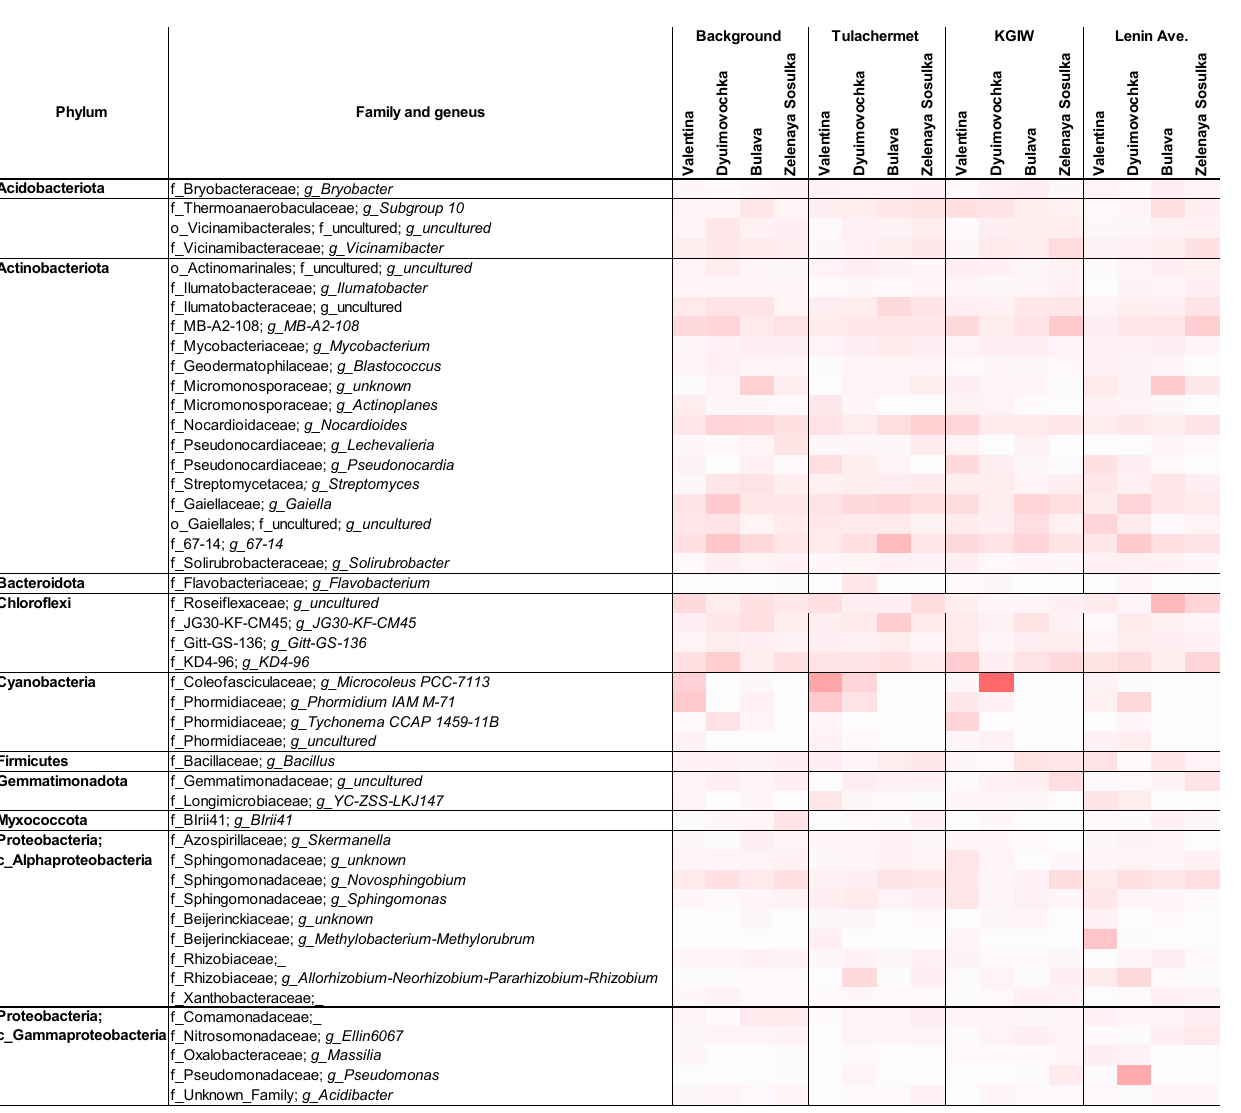
Figure 3. Heat map illustrating the relative abundances of OTUs associated at the genus level of the microbial communities in the rhizospheres of four amaranth cultivars grown on different soils.